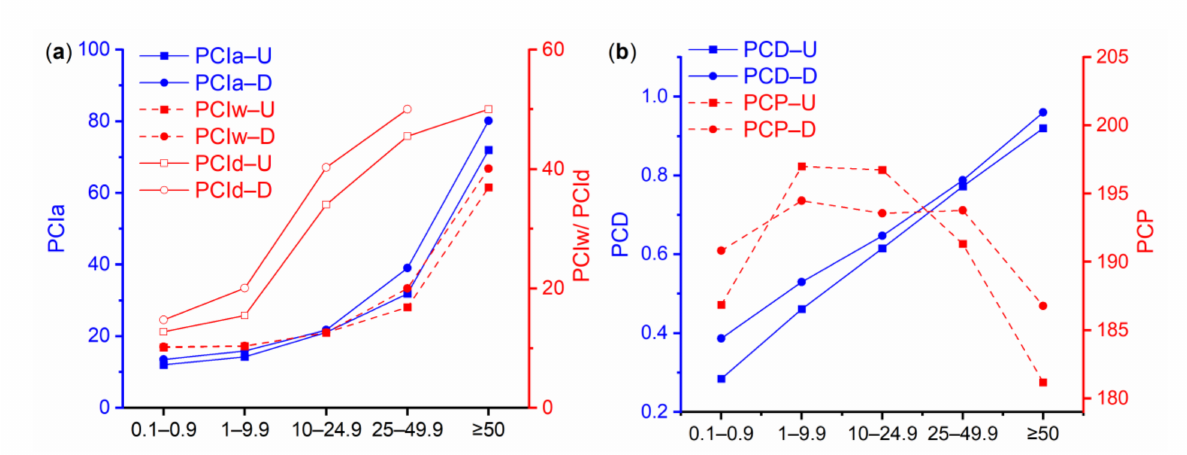
Figure 4. The annual average of ( a ) PCI and ( b ) PCD and PCP in each intensity in the upper and lower basins. –U is the value for the upper basin; –D is the value for the lower